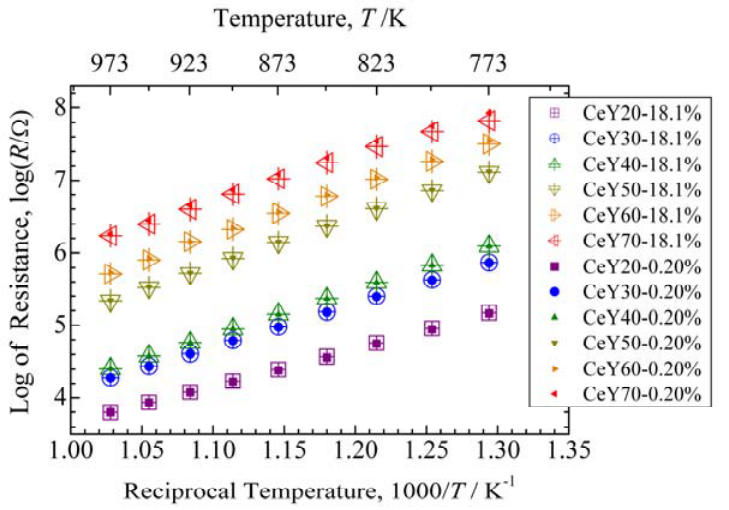
Figure 3. Resistance of thick films with various Y concentrations in the range from 773 to 973 K. “CeYx” indicates a composition of Ce composition indicate oxygen